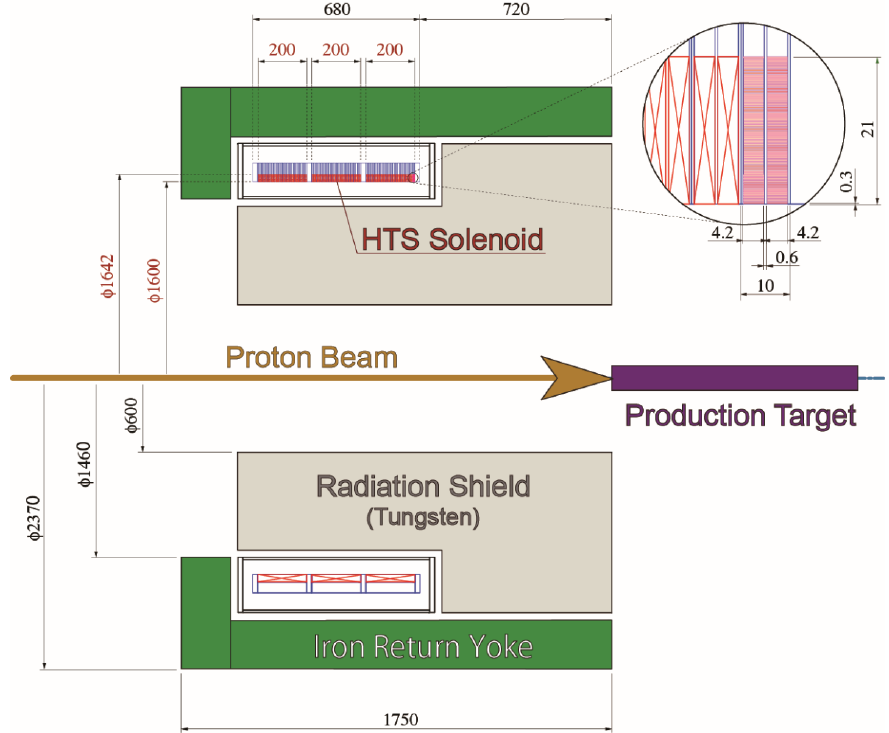
Figure 7. Muon production solenoid design J-PARC MLF TS2. Table 4. Main parameters of the muon production solenoid for J-PARC MLF second target TS2.